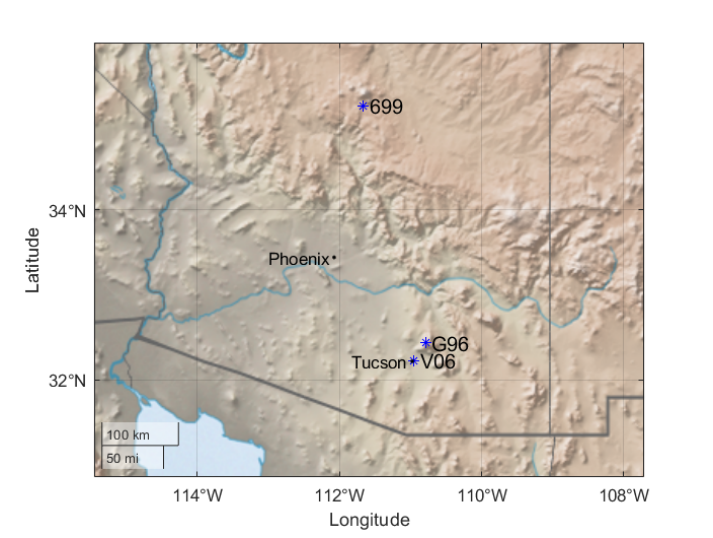
Figure 11. Coordinates of observatories 699, G96 and V06 marked on a geographic